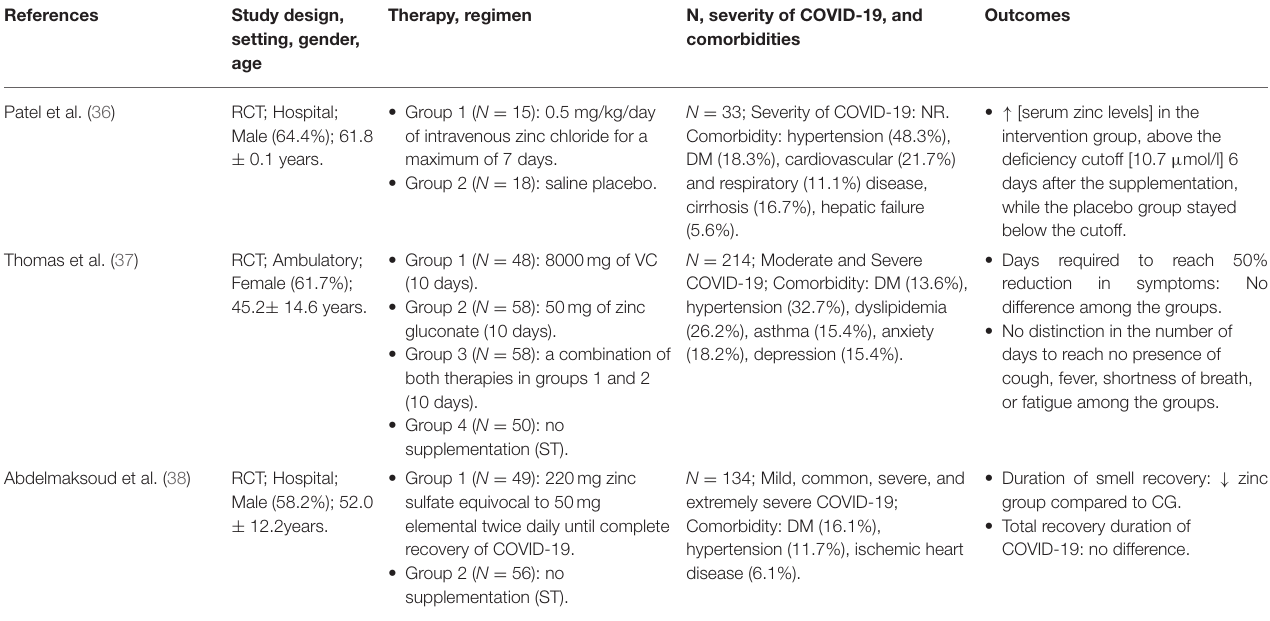
TABLE 2 | Summary of findings from studies that included zinc supplementation in the COVID-19